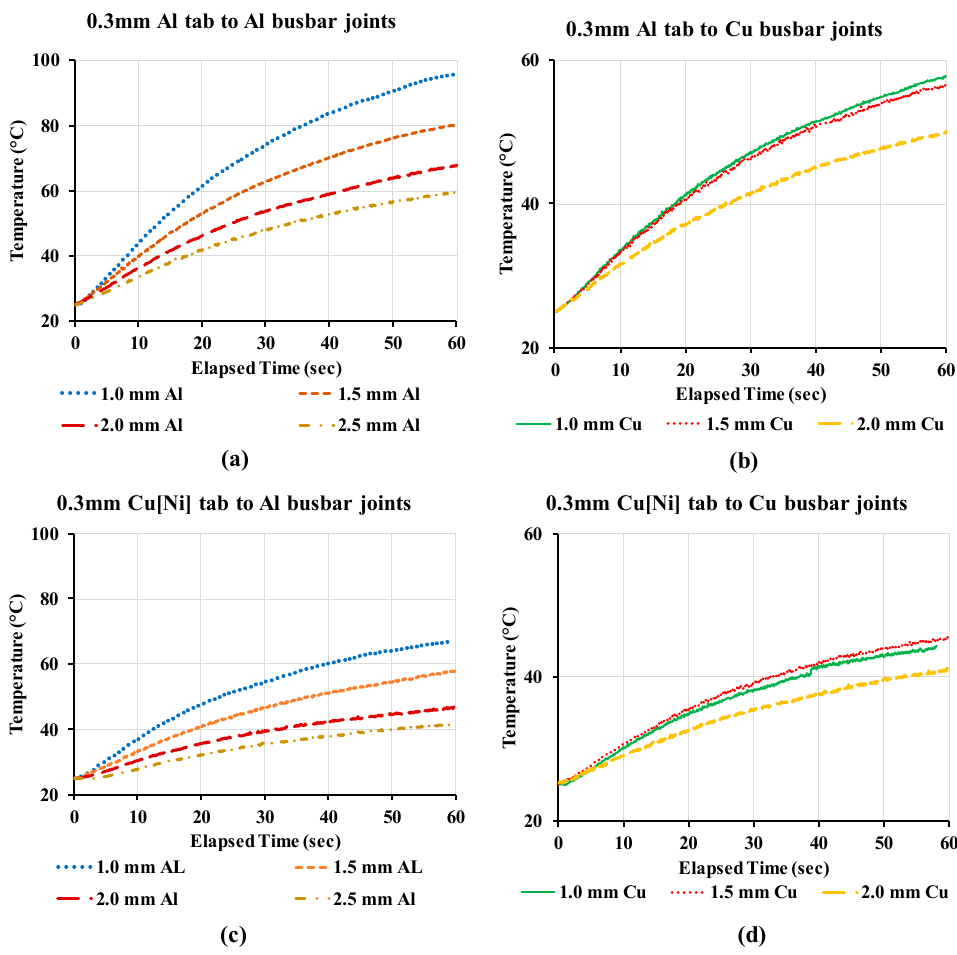
Figure 6. The temperature rise profiles due to application of 250 amp current for 60 s through ( a ) a 0.3 mm Al tab to different Al busbar joints; ( b ) a 0.3 mm Al tab to different Cu busbar joints; ( c ) a 0.3 mm Cu[Ni] tab to different Cu busbar joints; and ( d ) a 0.3 mm Cu[Ni] tab to different Cu busbar joints.